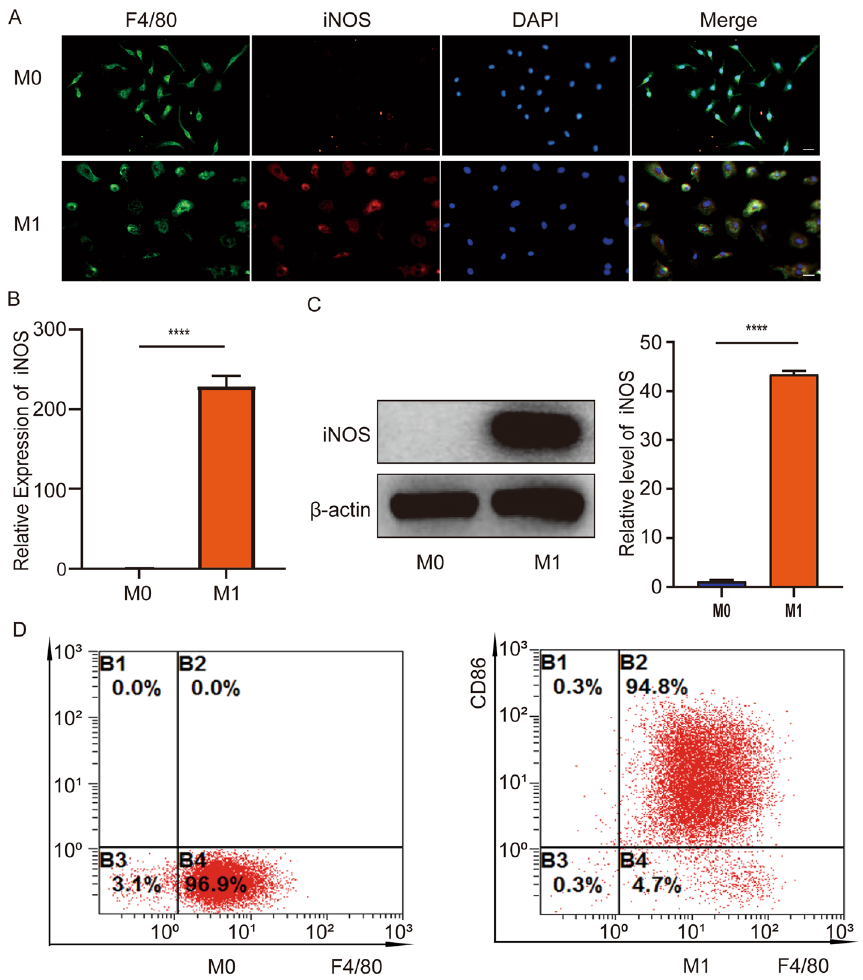
Fig. 1 Identification and induction of macrophages. A Immunofluorescence staining was performed. Red shows the M1 macrophage marker iNOS. Green shows macrophage marker F4/80. Blue shows nuclear staining (DAPI). Scale bar, 50 μm. B RT-PCR was used to detect the expression of iNOS in M0 macrophage groups and M1 macrophage groups. C The protein expression level of iNOS was determined by western-blotting analysis. D Identification of M0 (F4/80) macrophages and M1 macrophages (F4/80, CD86) by flow cytometry. n 3 per group. **** P < =